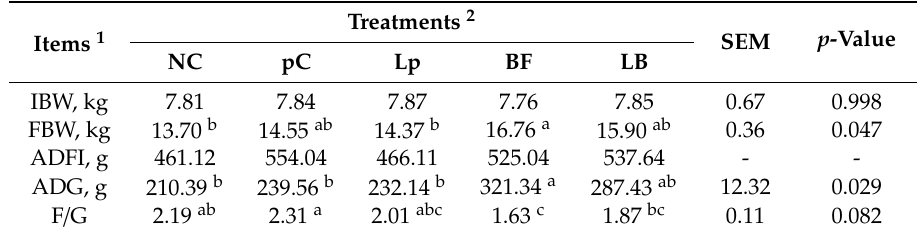
Table 2. E ff ects of L. plantarum , tartary buckwheat flavones, and their compound on growth performance of weaned piglets.